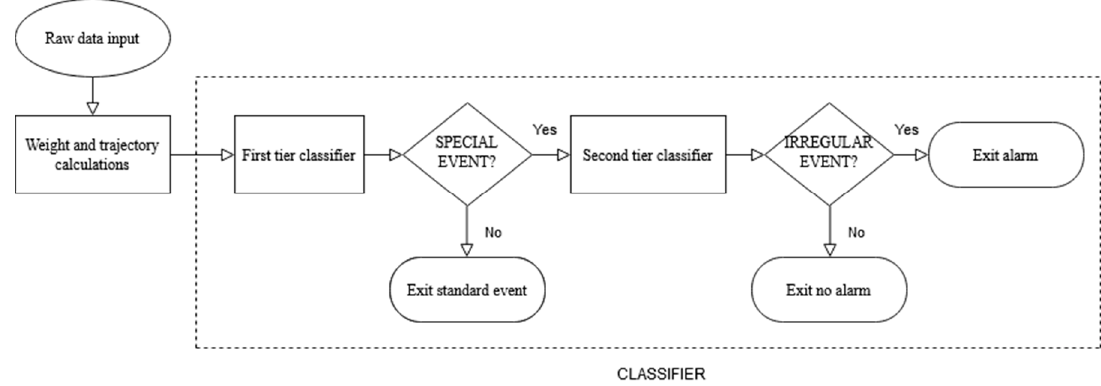
Figure 4. Data processing flow chart.